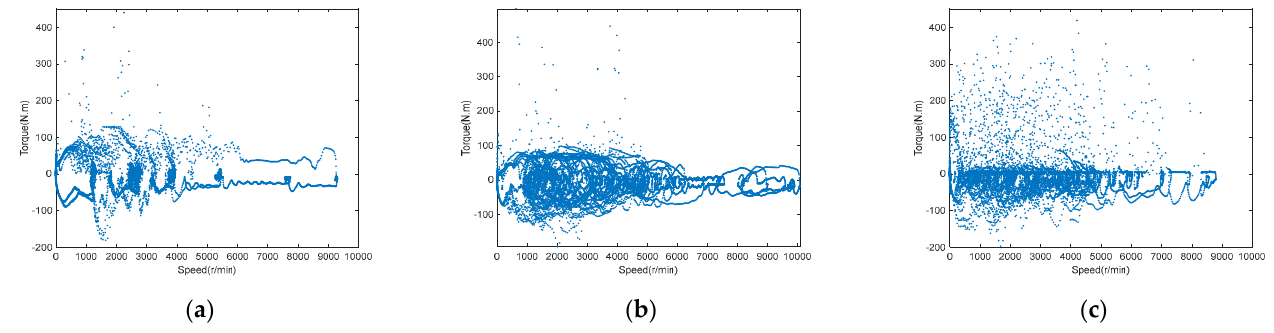
Figure 8. Distribution of the EDS under three typical cycles: ( a ) NEDC; ( b ) WLTC; ( c ) CLTC-P.